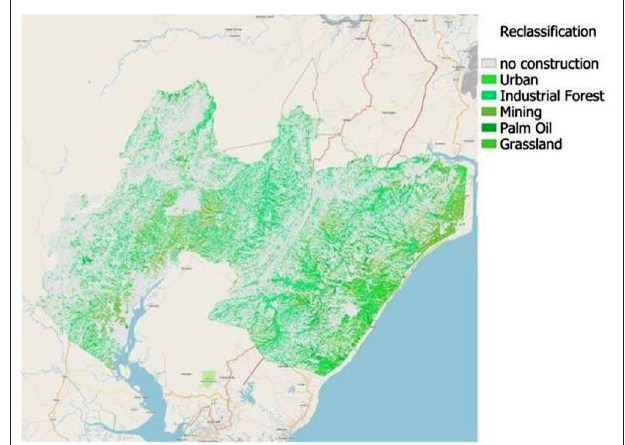
FIGURE 12 | Solar energy potential including slope and aspect.